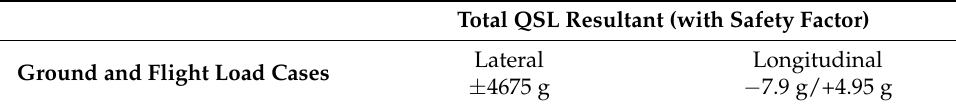
Table 2. Quasi-static loads (including safety factors).